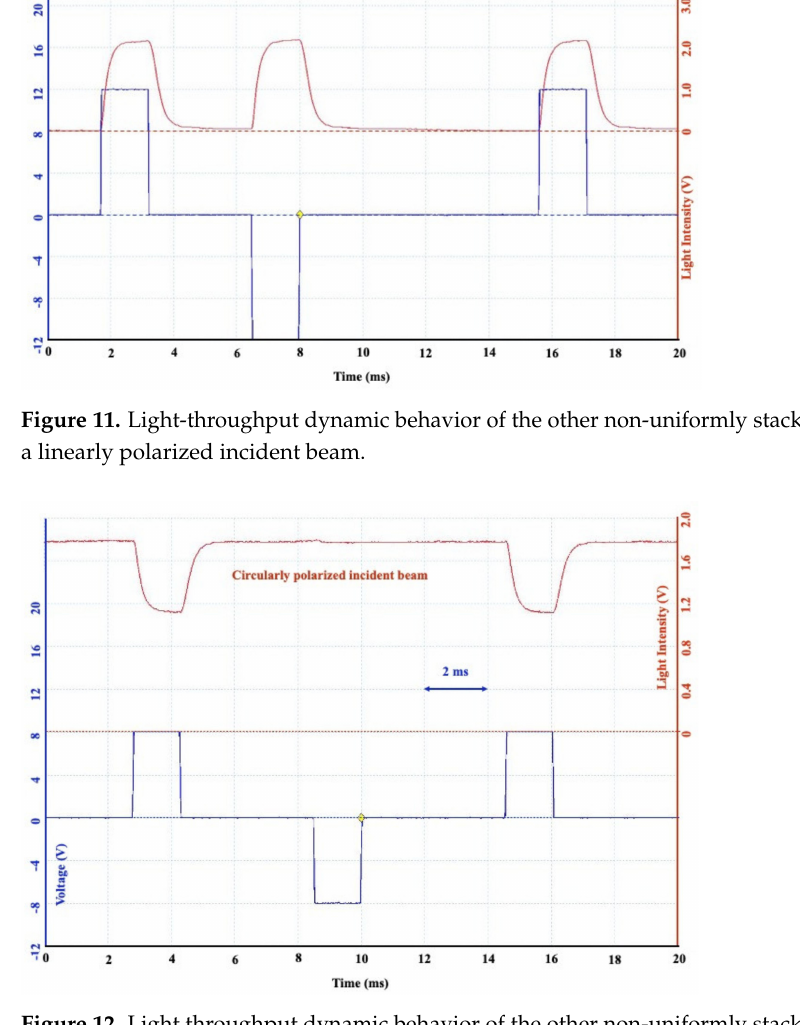
Figure 12. Light throughput dynamic behavior of the other non-uniformly stacked SSD-LC panel for a circularly polarized incident